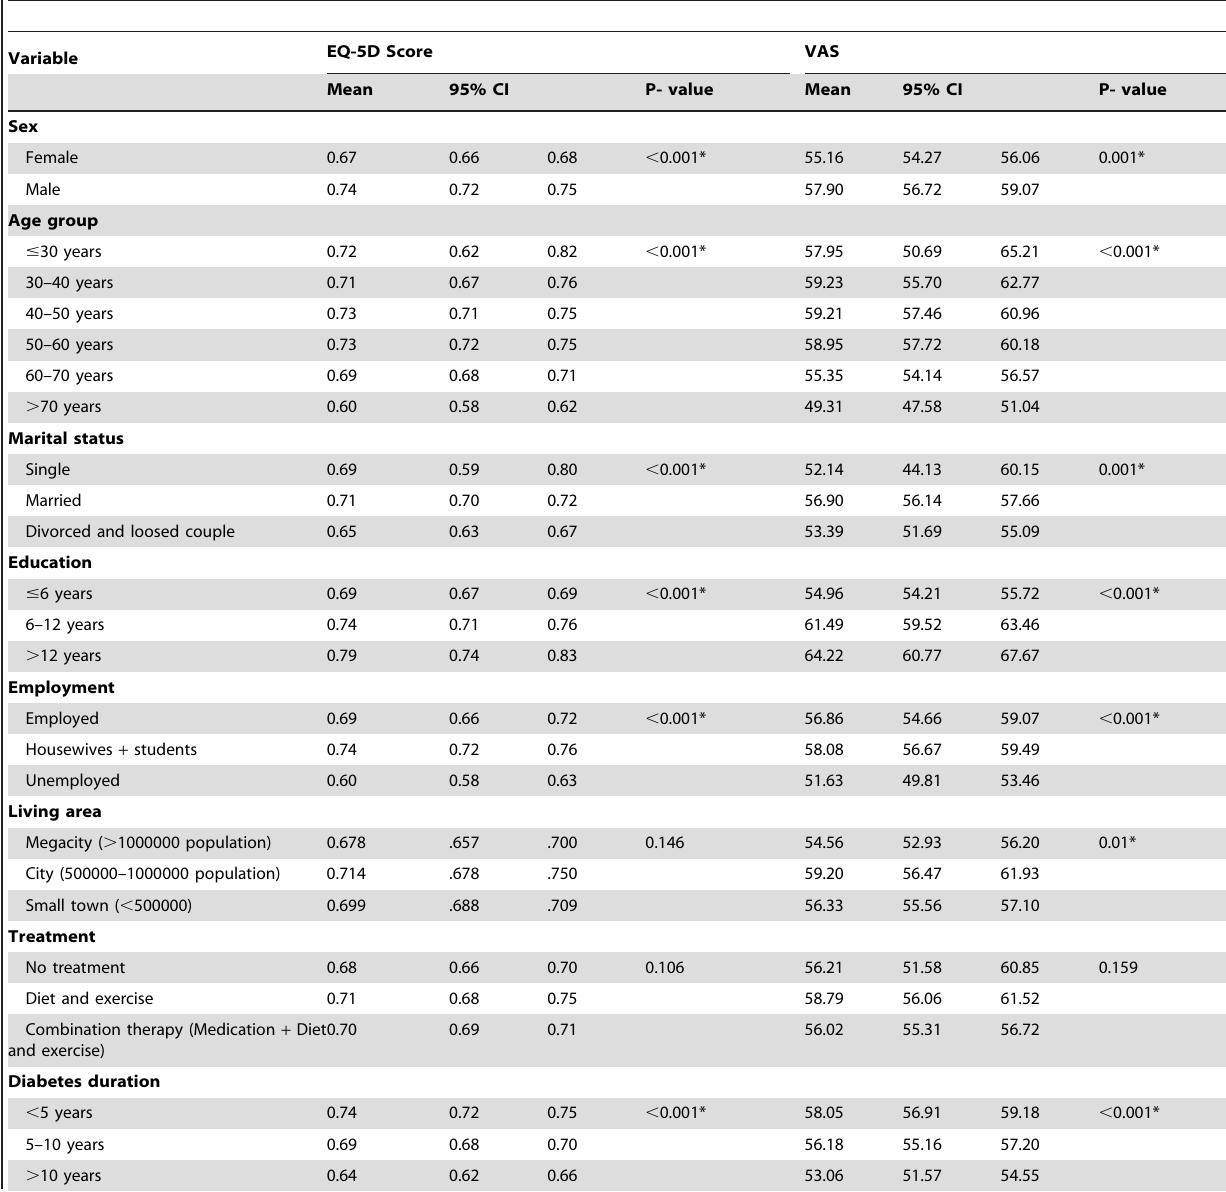
Table 3. EQ-5D and Visual Analog Scale (VAS)